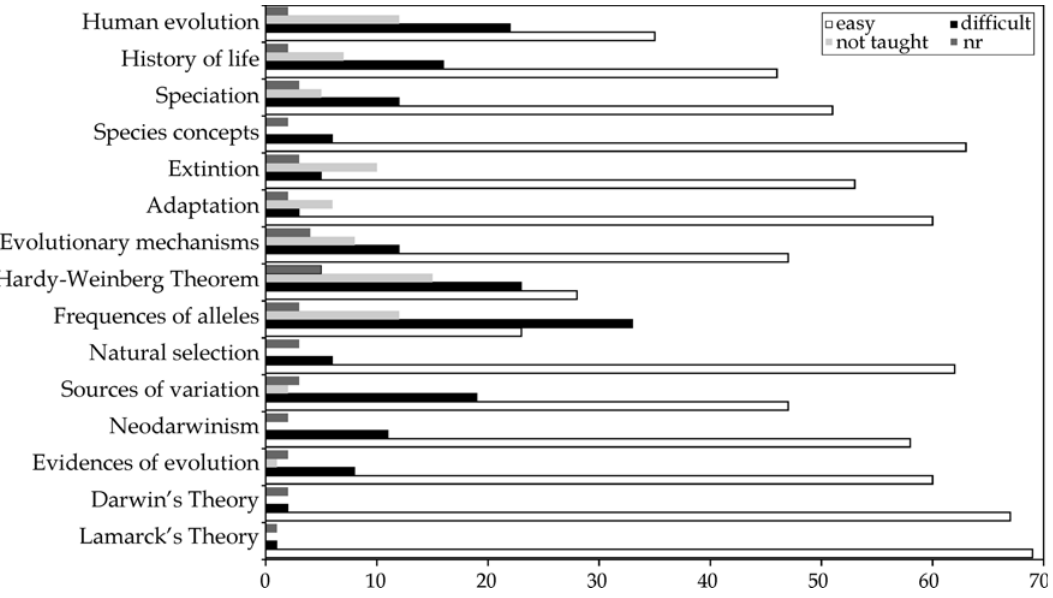
Figure 1 - Evaluation by teachers of the difficulty in teaching various topics in evolutionary